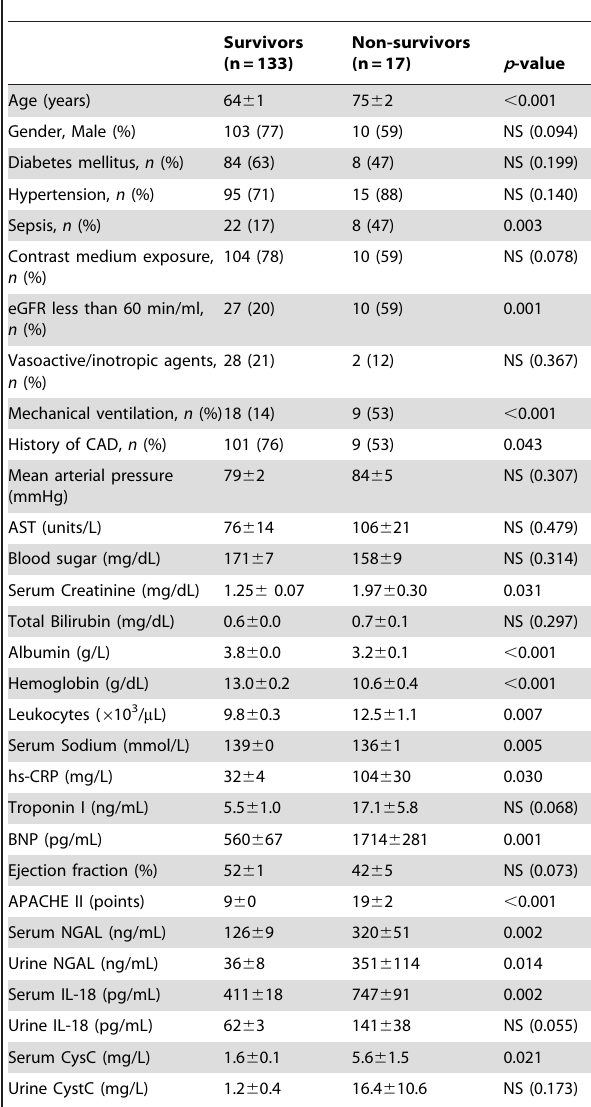
Table 4. Patient demographic data and clinical characteristics on the first of CCU admission according to 6-month mortality.